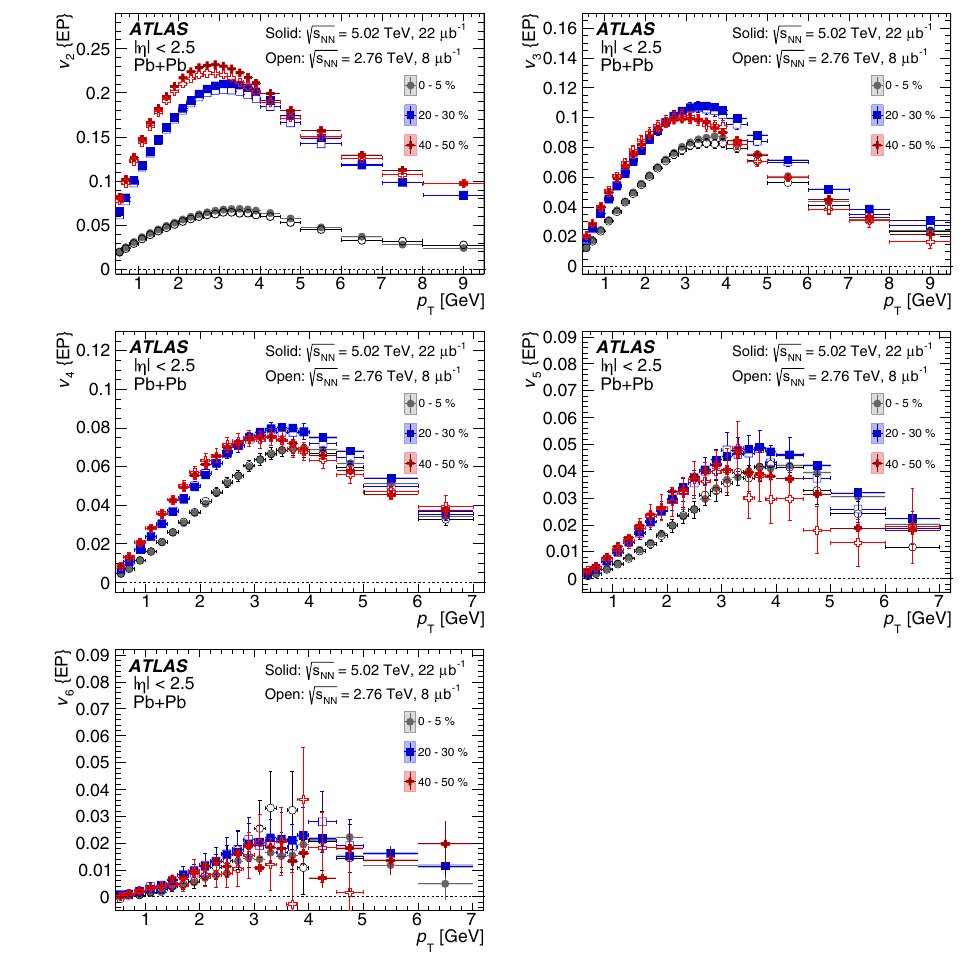
Fig. 10 Comparison of the v n obtained with EP method using Run1 and Run2 data as a function of p T . The results are shown in three centrality intervals: 0–5%, 20–30% and 40–50%. Results are averaged over the intervals indicated by horizontal error bars. The vertical error bars indicate statistical uncertainties. The shaded areas indicate systematic uncertainties